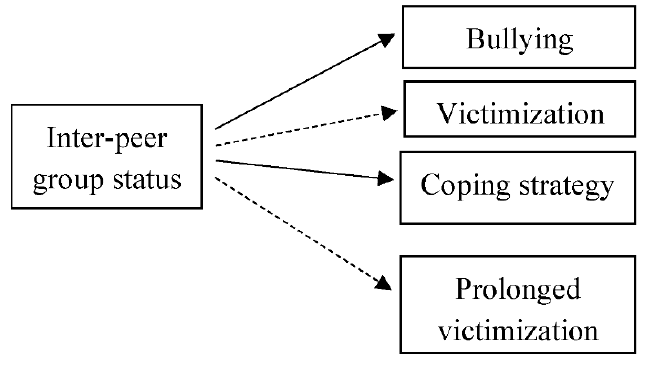
Figure 1. The visualized purpose of the current study.